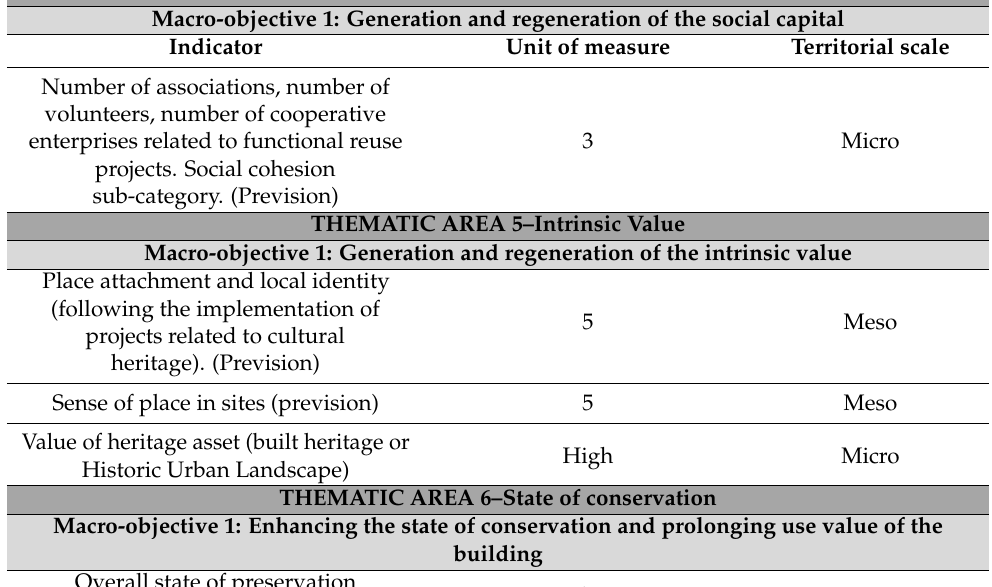
THEMATIC AREA 4–Social